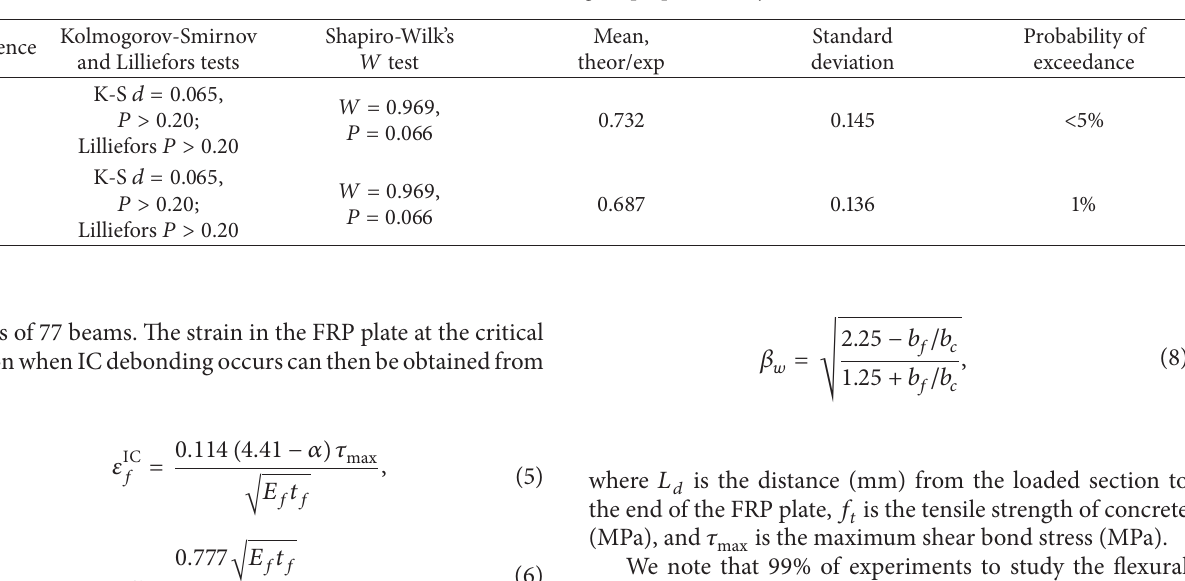
Table 4: Results of statistical modeling for proposed analytical